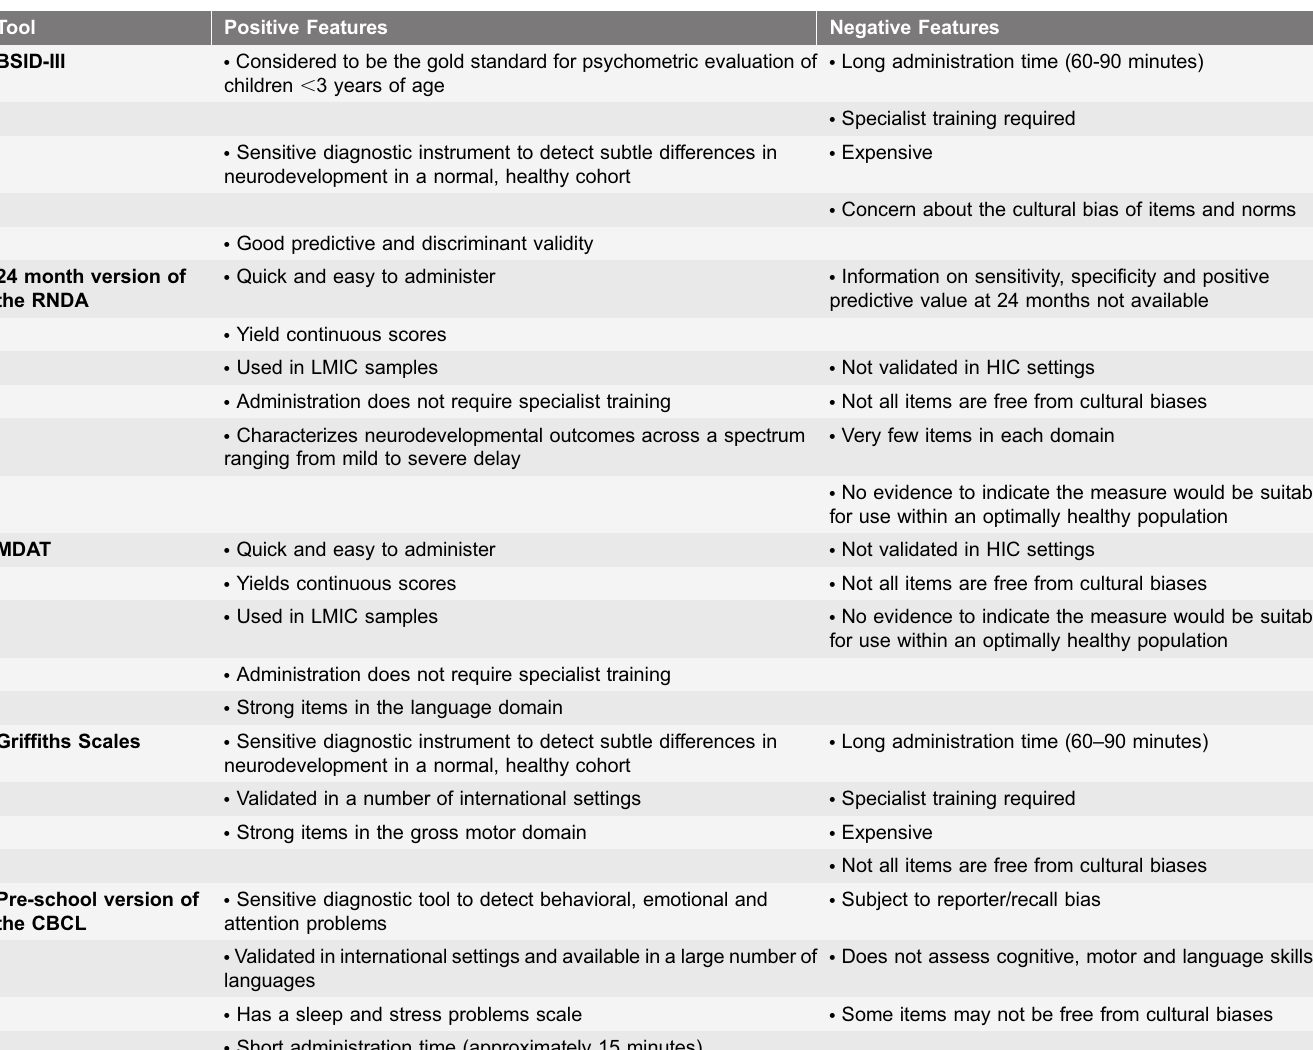
Table 5. Neurodevelopment tools selected following review of candidate tools by scientific advisory panel.